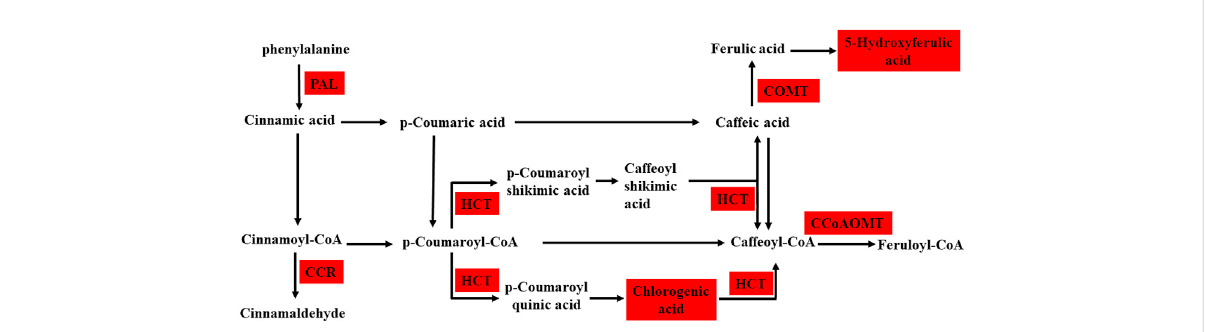
FIGURE 6 Schematic diagram shows phenylpropanoid and fl avonoid biosynthesis between the control and AR-Cd treated groups, the red box indicates the common upregulated DEGs and DEMs. This pathway is constructed based on the KEGG pathway. Genes that are differently expressed include